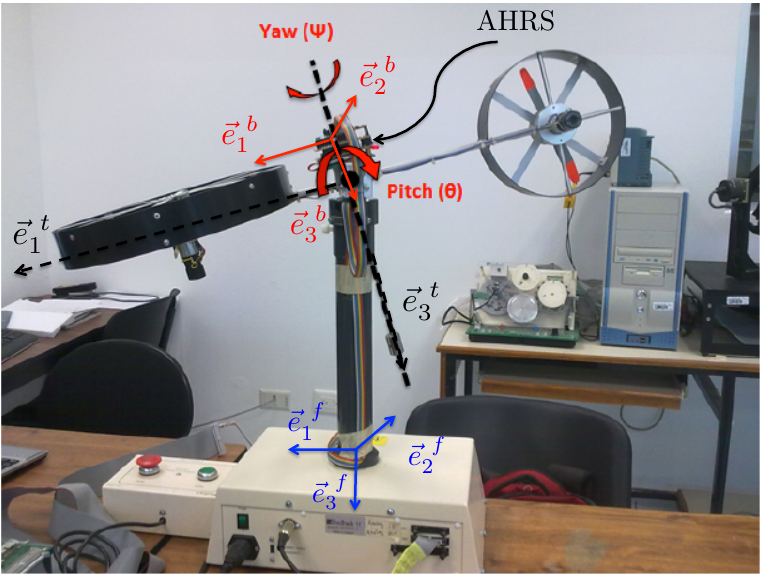
Figure 6. Experimental